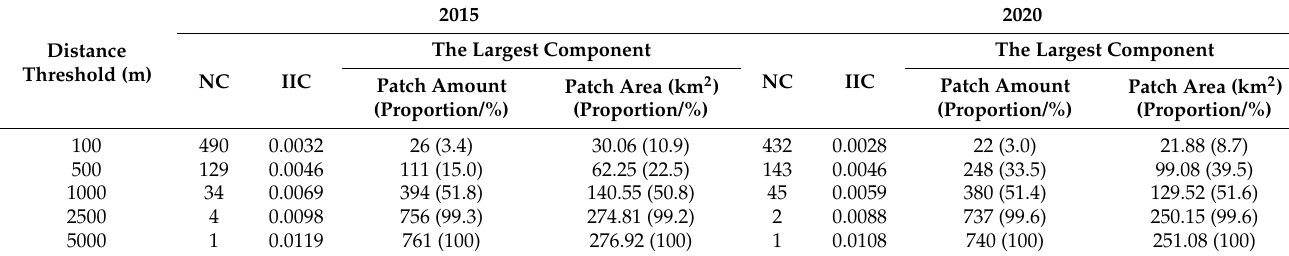
Table 2. FLC indices of hills under different distance thresholds.